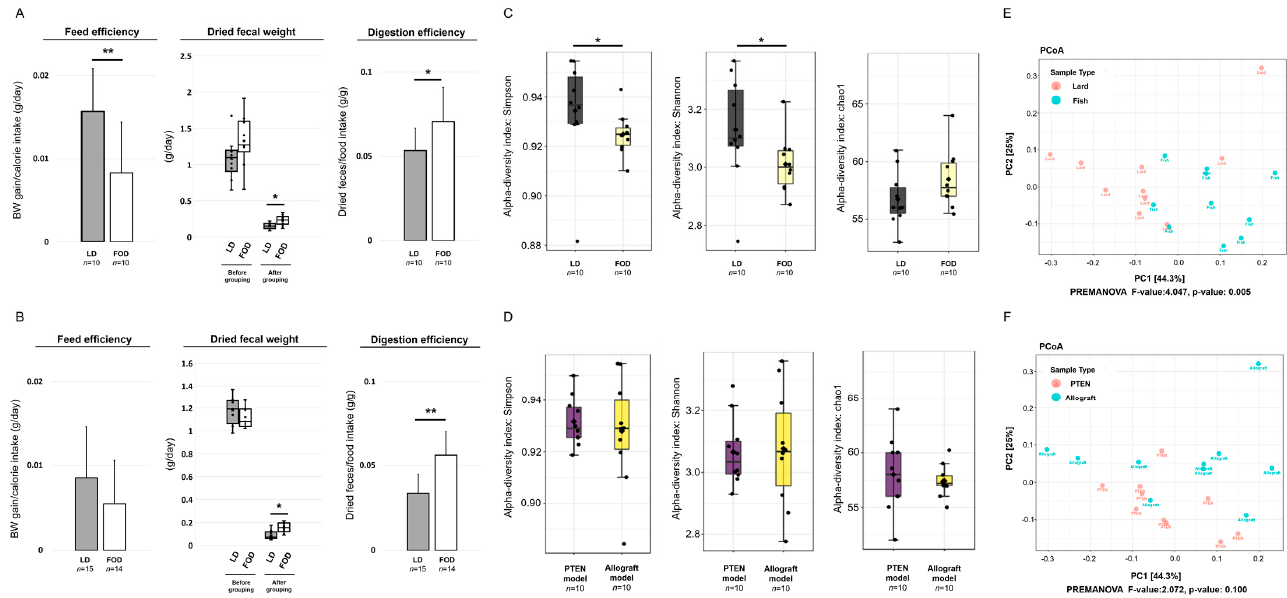
Figure 2. Digestive efficacy, fecal characteristics, and divergency of gut microbiota in two mouse models. * p < 0.05, ** p < 0.01. ( A ) Feed efficiency, dried fecal weight, and digestion efficiency of the Pten KO mice fed with LD or FOD ( n = 10, 10, respectively). The line within a box indicates the median value. The round dots and cross marks indicate the value of each sample and the mean value, respectively. ( B ) Feed efficiency, dried fecal weight, and digestion efficiency of TRAMP-C2 allograft mice fed with LD or FOD ( n = 15, 14, respectively). The line within a box indicates the median value. The round dots and cross marks indicate the value of each sample and the mean value, respectively. ( C ) Comparison of alpha-diversity in gut microbiome according to the difference in experimental diets ( n = 10, 10, respectively). The line within a box indicates the median value, and black dots indicate the value of each sample. ( D ) Comparison of alpha-diversity in gut microbiome according to the types of mouse models ( n = 10, 10, respectively). The line within a box indicates the median value, and black dots indicate the value of each sample. ( E ) Comparison of beta-diversity in gut microbiome according to the difference in experimental diets. ( F ) Comparison of beta-diversity in gut microbiome according to the types of mouse models. LD, lard diet; FOD, fish oil diet .